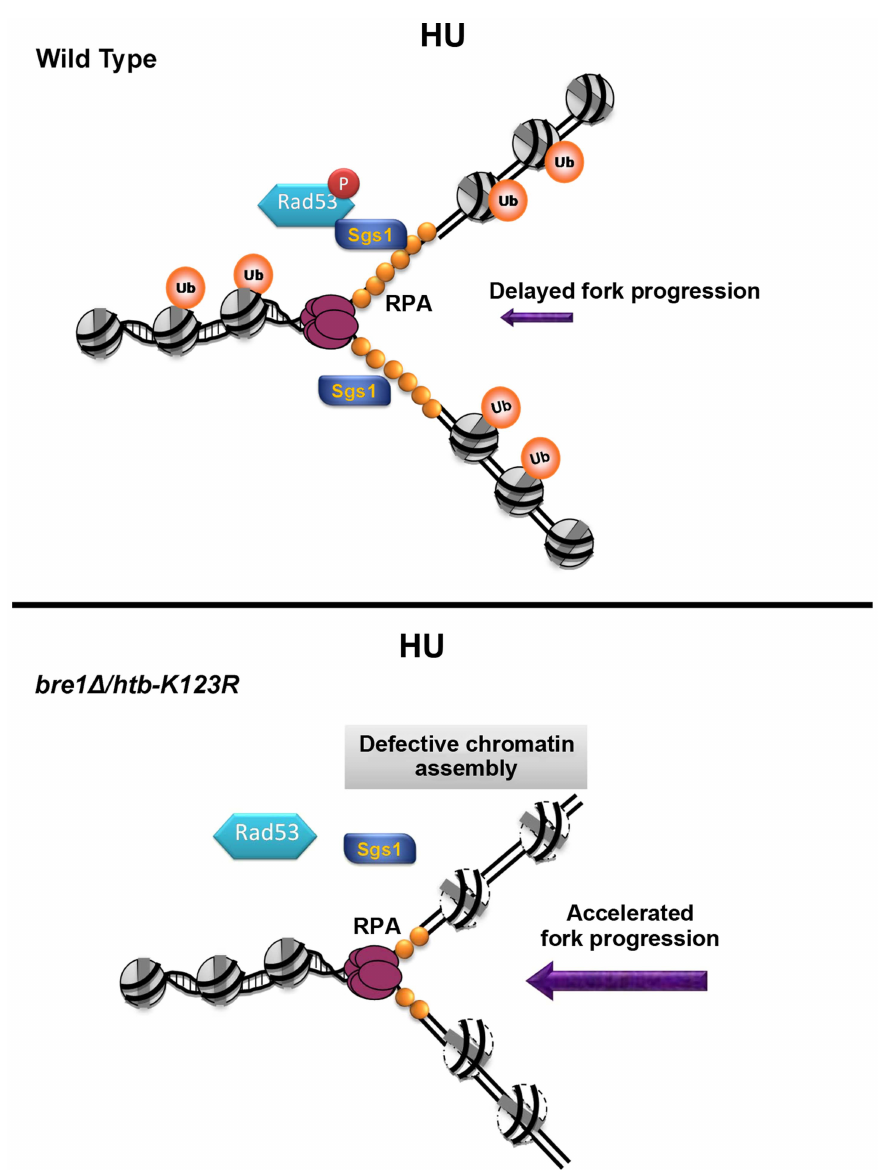
Figure 8. A model for how H2B mono-ubiquitylation facilitates fork stability under replication stress. Upon HU-induced stress, H2Bub promotes nucleosome assembly, which assists replication fork stalling, Sgs1 recruitment, and Rad53 phosphorylation. The reassembly of chromatin on nascent DNA restricts fork progression and promotes replication fork stability and its recovery after the removal of HU. In the absence of H2Bub ( bre1 D /htb-K123R ), replication fork movement is faster than even that observed under nucleotide depletion by HU, which results in shorter tracts of RPA-coated-single-stranded DNA. This in turn reduces retention of Sgs1 at the forks, and delays phosphorylation of Rad53.